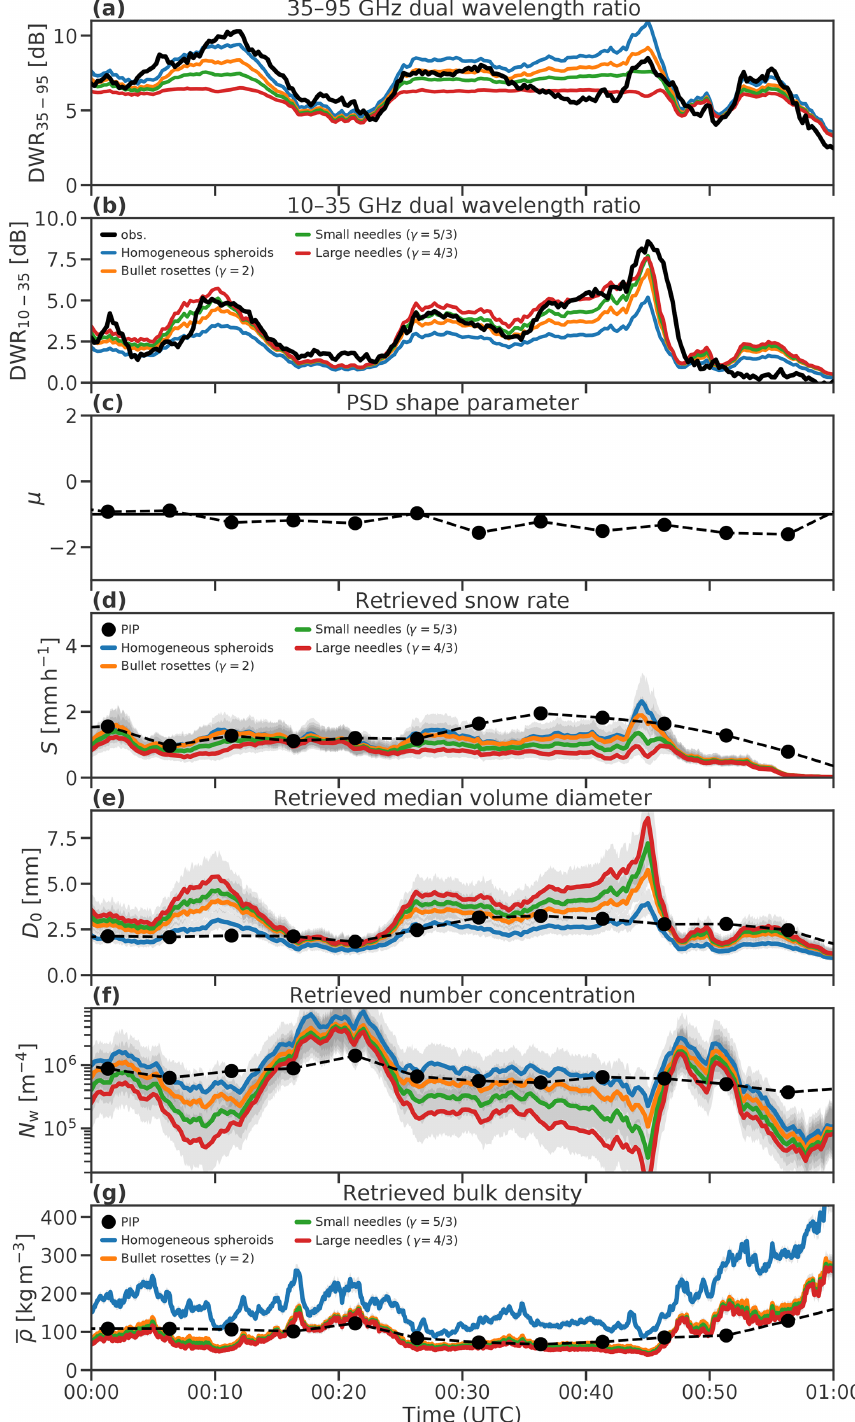
Figure 13. Triple-frequency Doppler radar retrievals from the 16 February 2014 case during BAECC, assuming homogeneous spheroids, aggregates of bullet rosettes, and aggregates of large and small needles. The forward-modelled 35–95GHz (a) and 10–35GHz (b) dual- frequency ratios are compared against radar measurements. The assumed PSD shape parameter µ = − 1 for all the retrievals reflects the near-constant in situ measurements throughout the case (c) . The retrieved snow rate (d) , median volume diameter (e) , normalized number concentration (f) and bulk density (g) at 500m above ground level are compared against PIP measurements at the